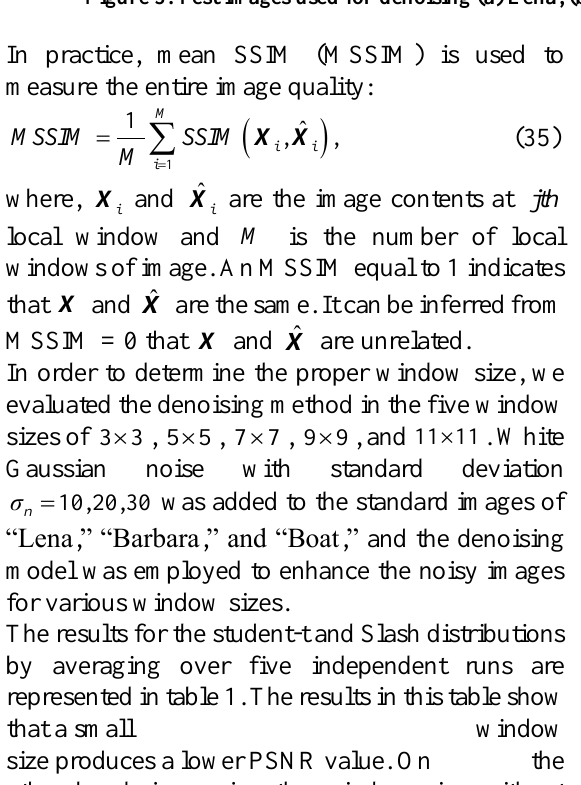
Figure 3. Test images used for denoising (a) Lena, (b) Barbara, (c) Boat, (d) Bridge, (e) Mandrill, (f)